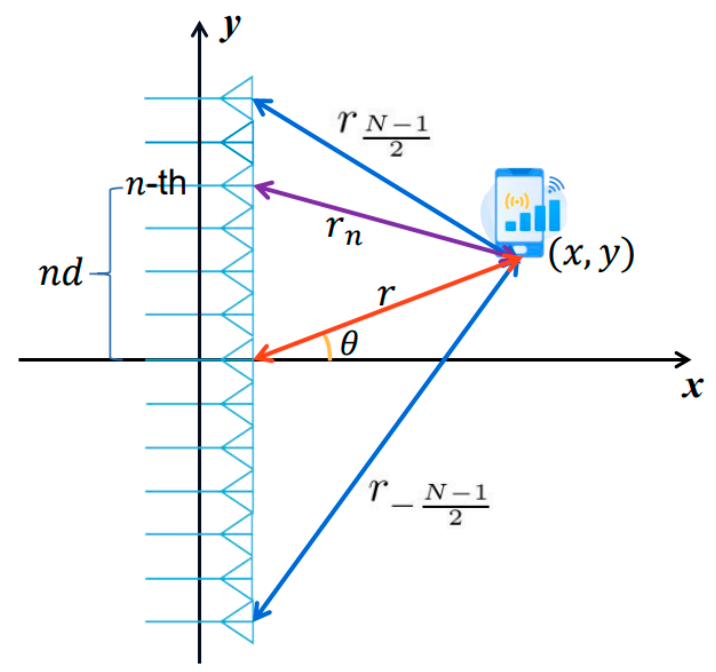
Figure 17. Near-field system model [67]. Table 2. Comparison among various studies conducted in the field of beam squint from 2012 to 2022.